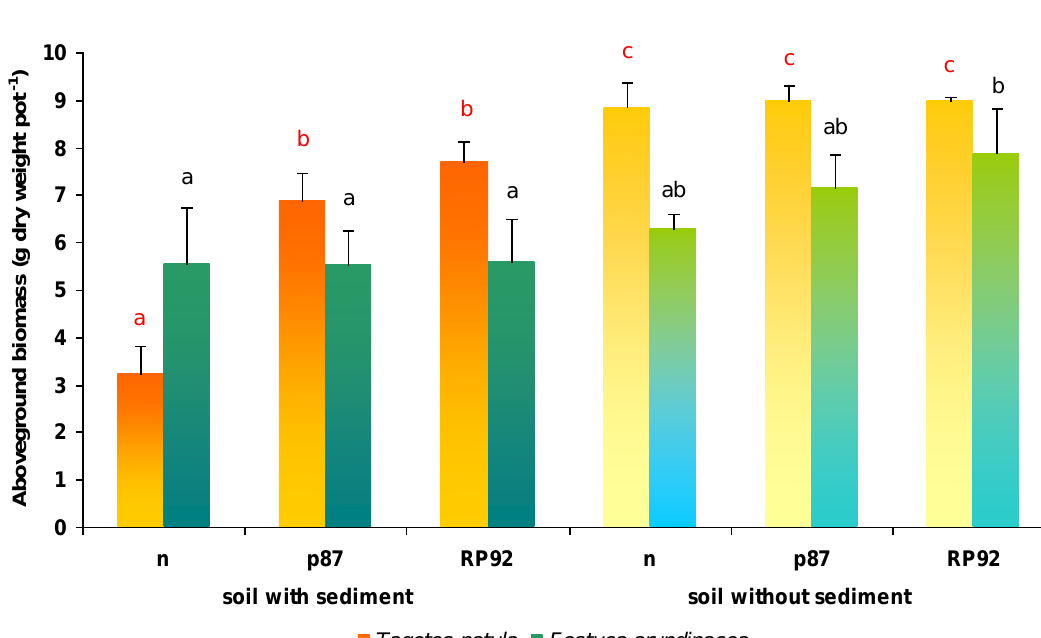
Figure 2. Yield of T. patula and F. arundinacea grown on control soil and soil amended with bottom sediments, with or without (n) inoculation with bacterial strain p87 or RP92. The same letters denote groups that did not significantly differ (at p < 0.05; the Duncan post hoc test). Statistical significance was measured for each plant separately and the results were marked by different colors.